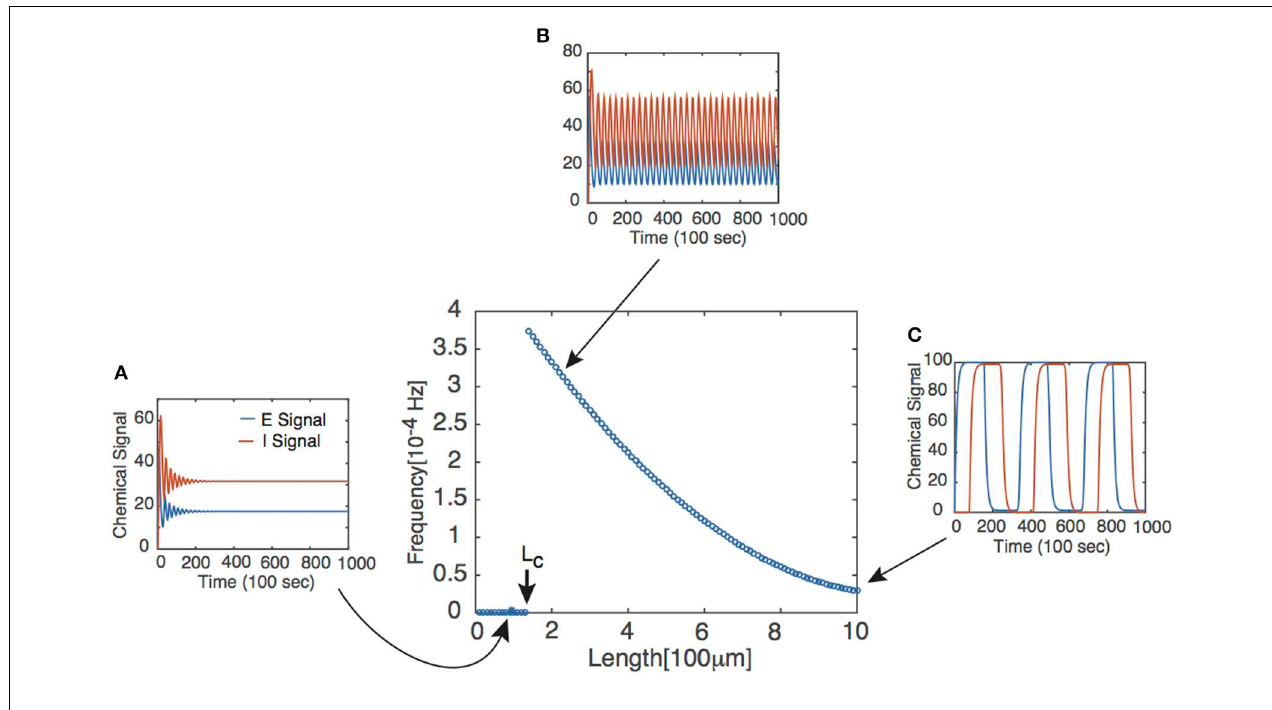
FIGURE 2 | Frequency of periodic solutions plotted against axonal length. [Plot was obtained by looking at the power spectrum of the retrograde signal and taking the frequency of the signal to be where the sharp peak of the spectrum occurred.] Insets